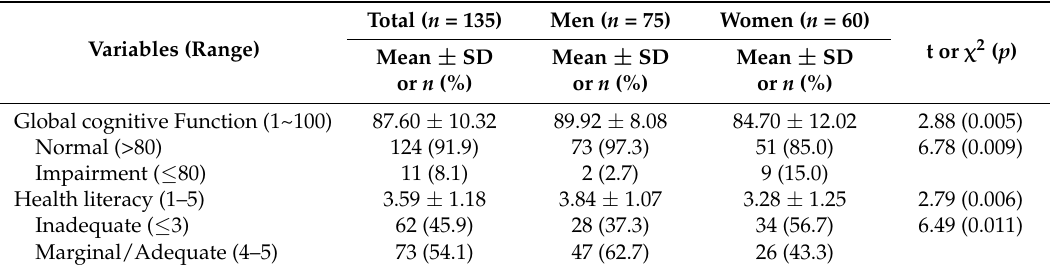
Table 2. Difference in cognitive function and health literacy by